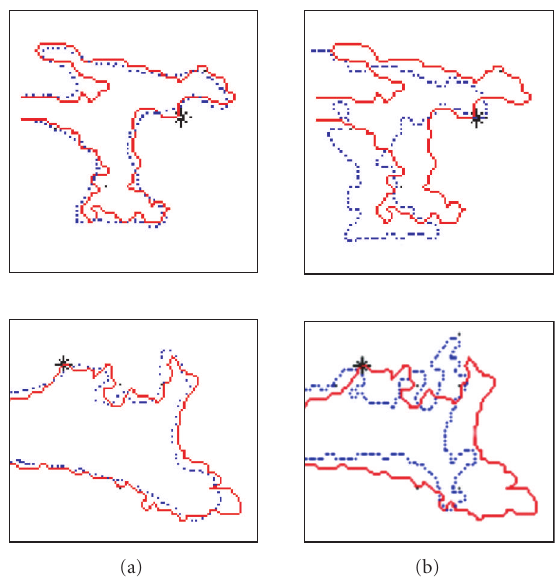
Figure 7: Registered boundaries of two selected regions: (a) using the deformable sheet-curve model, and (b) using TPS with feature points